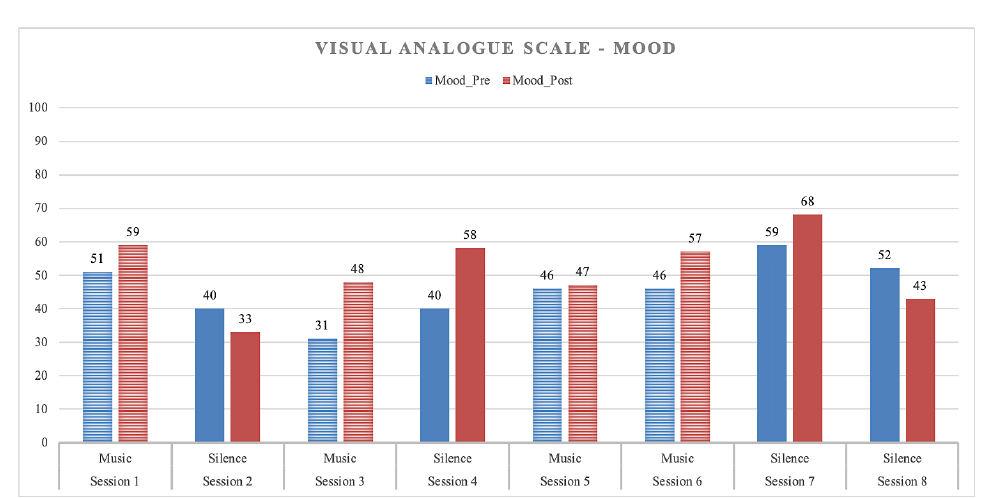
FFigigururee 33 Pre- and post-treatment scores for mood completed before and after each treatment in all sessions.